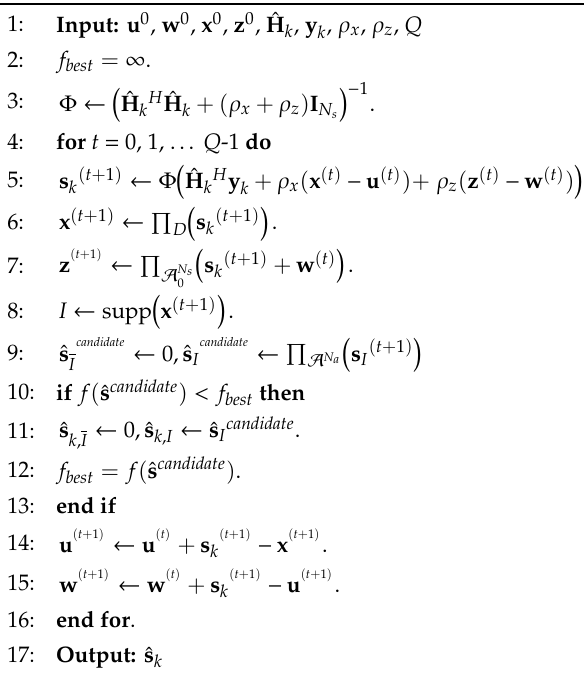
Table 2. Iterative GSM detection algorithm for each user k